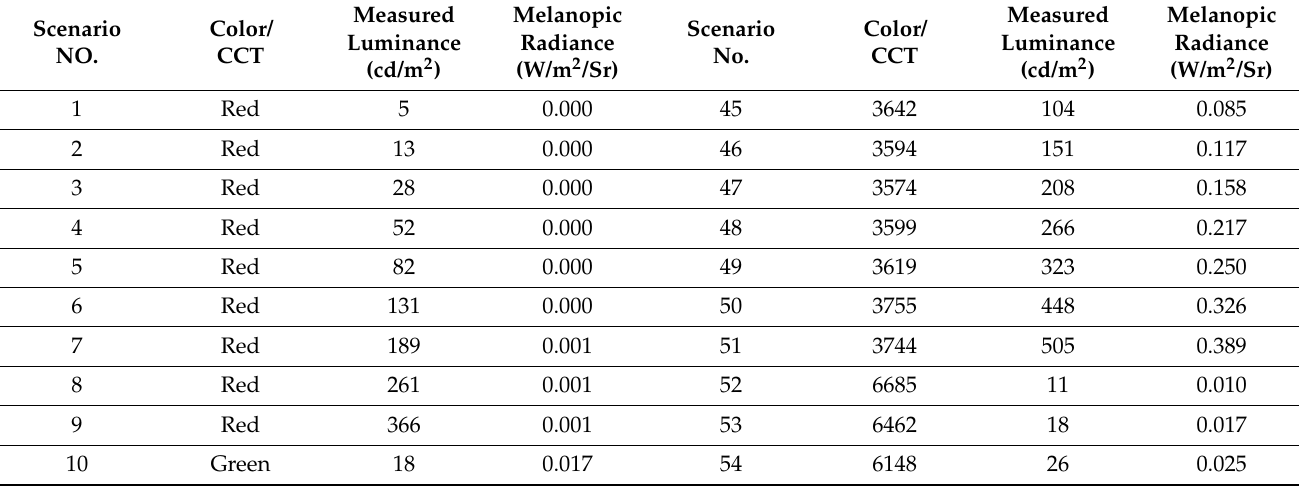
Figure 3. The eight spectra of the experimental scenarios. Table 2. Detailed information on the scenarios for the experiment.